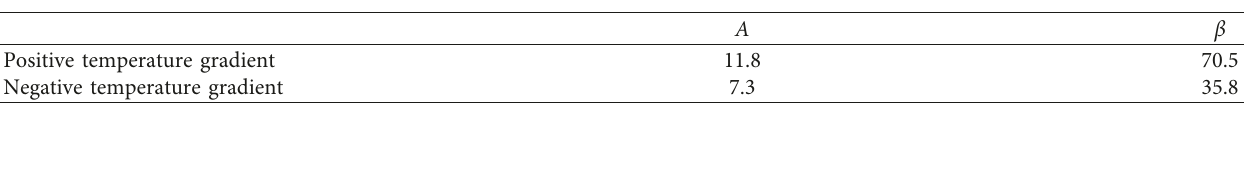
Table 3: The statistical parameters of the daily maximum annual distribution of temperature gradient.